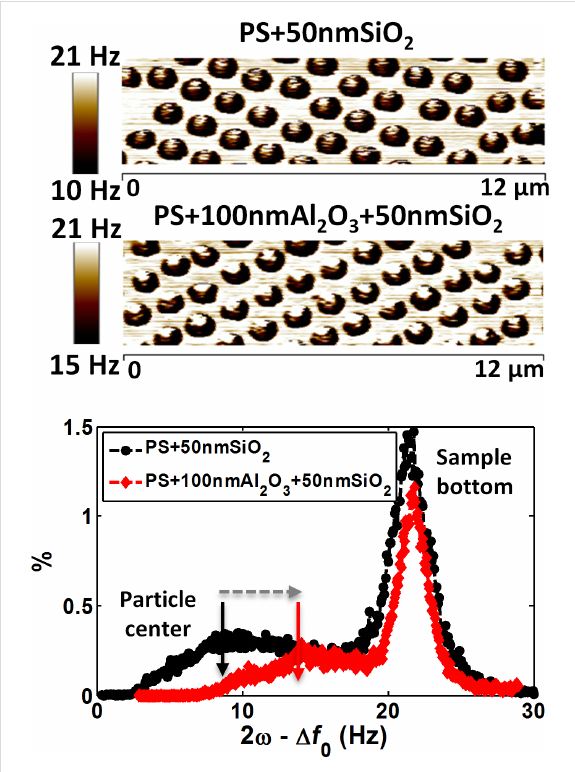
Figure 4: Approach 2: EFM images of PS + 50nmSiO 2 (upper) and PS + 100 nm Al 2 O 3 + 50 nm SiO 2 (middle panel) samples, and their corresponding EFM signal distribution histogram (bottom); z = 21 nm.